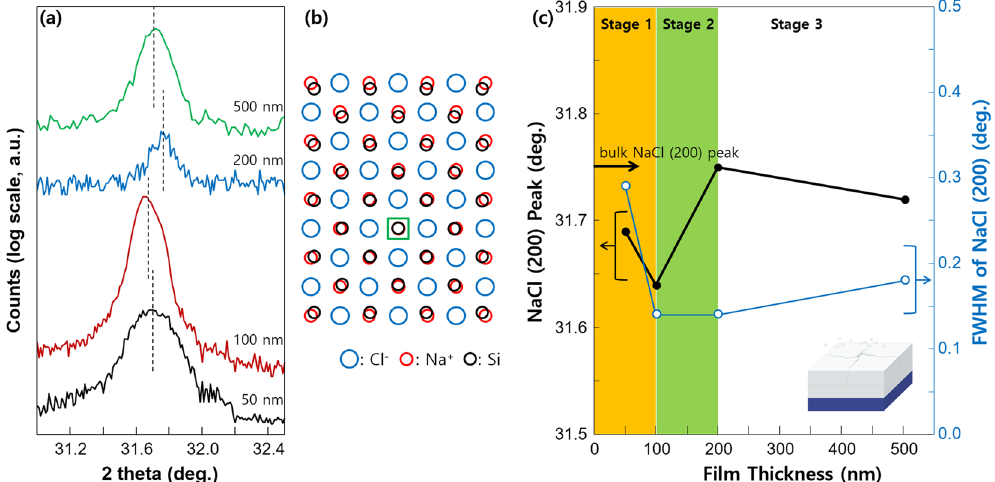
Figure 3. ( a ) Shift in the positions of NaCl(200) XRD peaks on Si(100) substrate. ( b ) Schematic representing the epitaxial growth of NaCl(100) on Si(100) substrate. ( c ) Peak positions and FWHM values of NaCl(200) peaks at different growth stages.